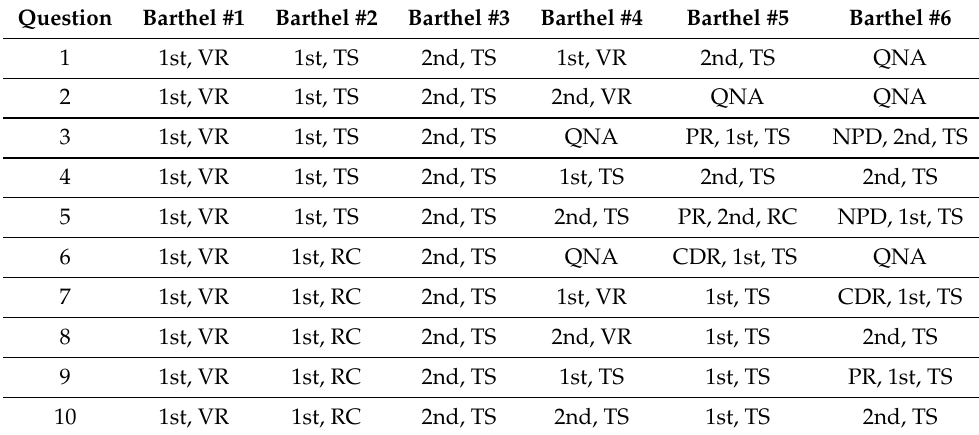
Table 2. Bathel tests used to validate our model. Legend: 1st